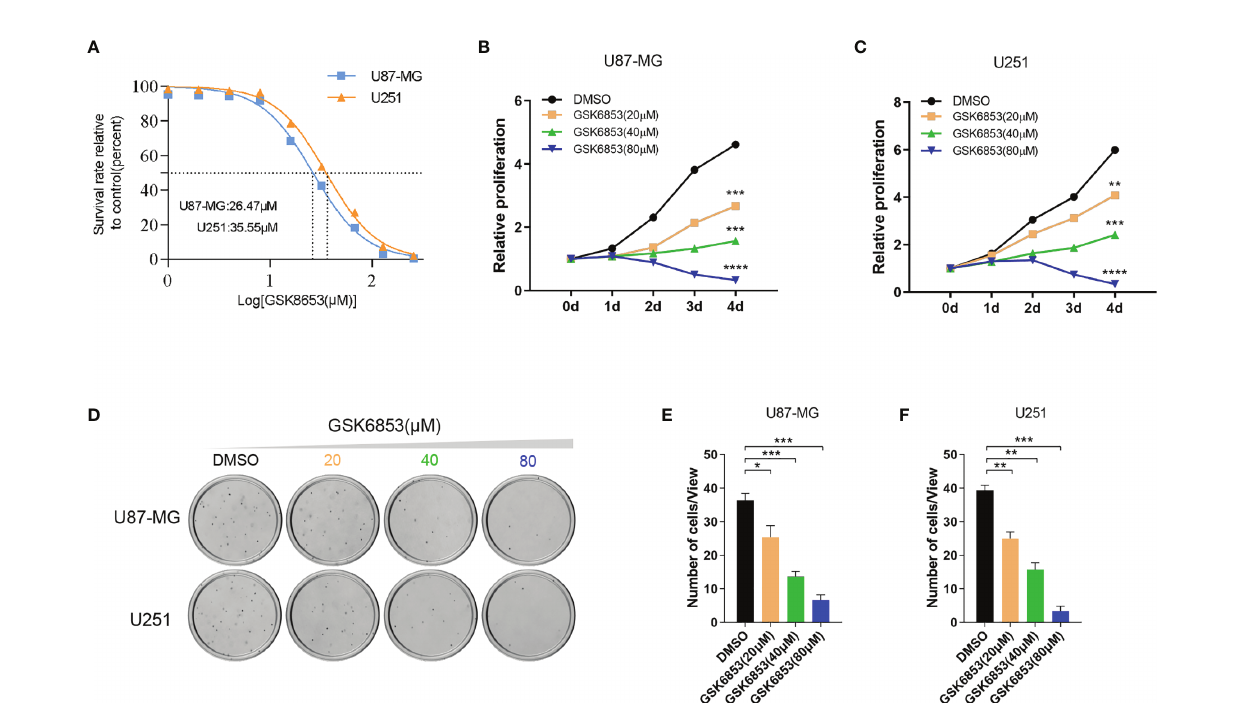
FIGURE 7 | Inhibition of BRPF1 function attenuated glioma cell proliferation and colony formation. (A) IC50 curve of GSK6853 in U251 and U87-MG cells. Proliferation of U87-MG (B) and U251 (C) cells treated with DMSO or GSK6853 was tested by CCK-8 assays. Colony formation assay of U87-MG and U251 cells treated with DMSO or GSK6853 for three weeks (D) and the number of cell clones (E, F) . *p < 0.05; **p < 0.01; ***p < 0.001; ****p < 0.0001, two-tailed unpaired